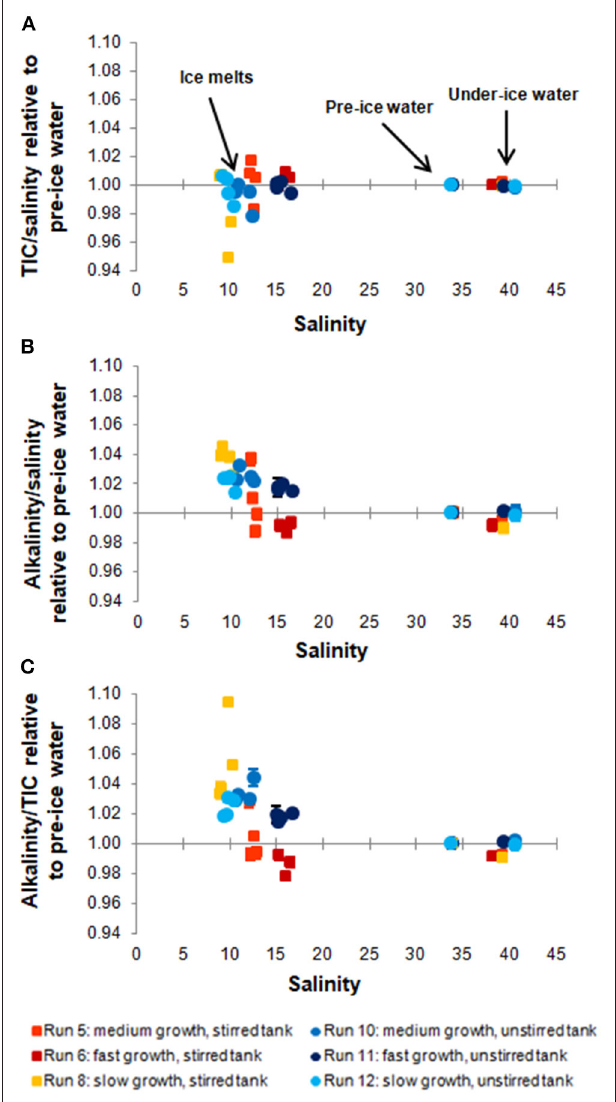
FIGURE 3 | Ratios between TIC and salinity (A) , A T and salinity (B), and A T and TIC (C) of the sampled ice melts, pre-ice, and under-ice water. For all experimental runs, the data points were normalized to the ratio of the pre-ice water sample, so as to illustrate changes in the ratios during ice growth. Uncertainties were calculated from deviations between